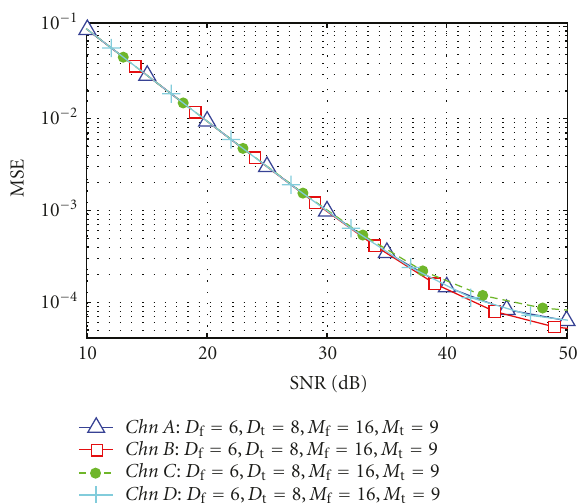
Figure 5: MSE versus SNR of 2 × 1D-PACE for various channel models, D f = 6, D t = 8, M f = 16, M t = 9.